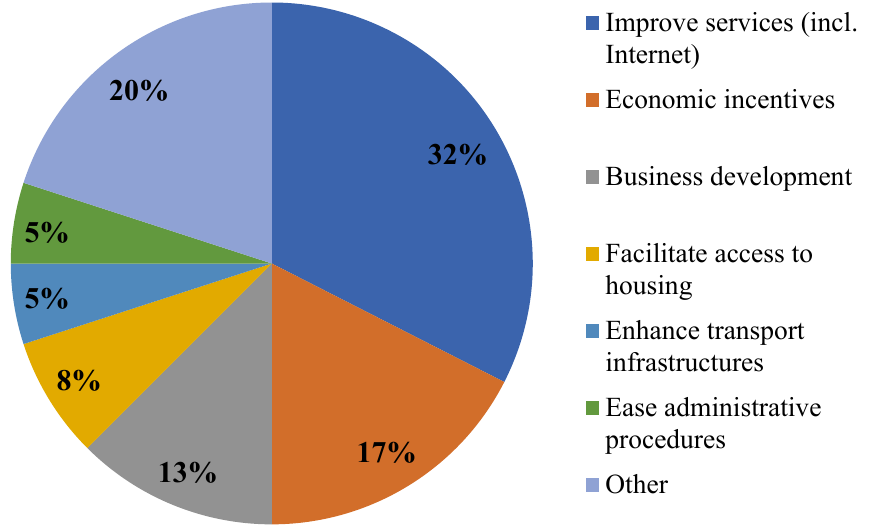
Figure 5. Experts’ main recommendations to revert depopulation in protected municipalities.